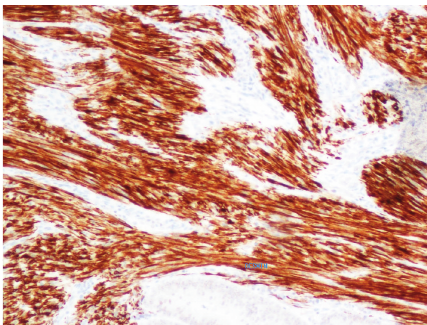
Figure 6: Positive staining for desmin in the sarcomatous compo-